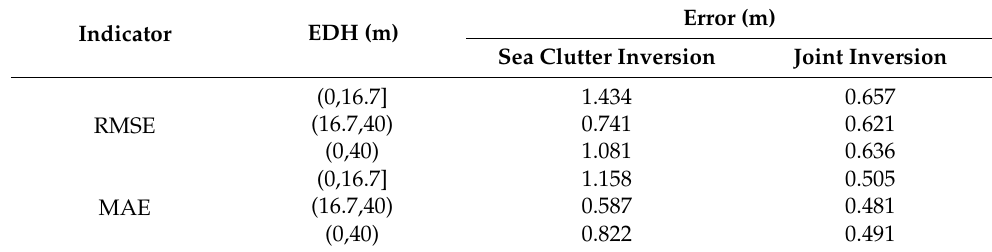
Table 2. Errors of Sea clutter inversion and joint inversion.